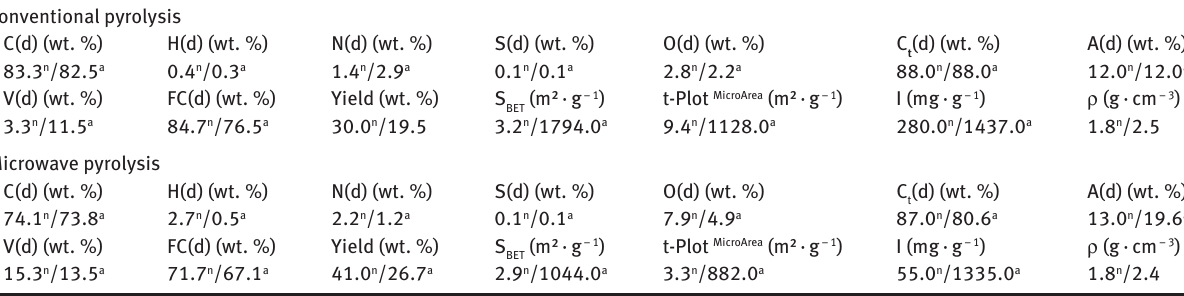
Table 2: Proximate and ultimate analysis, S samples after conventional and microwave pyrolysis. Conventional